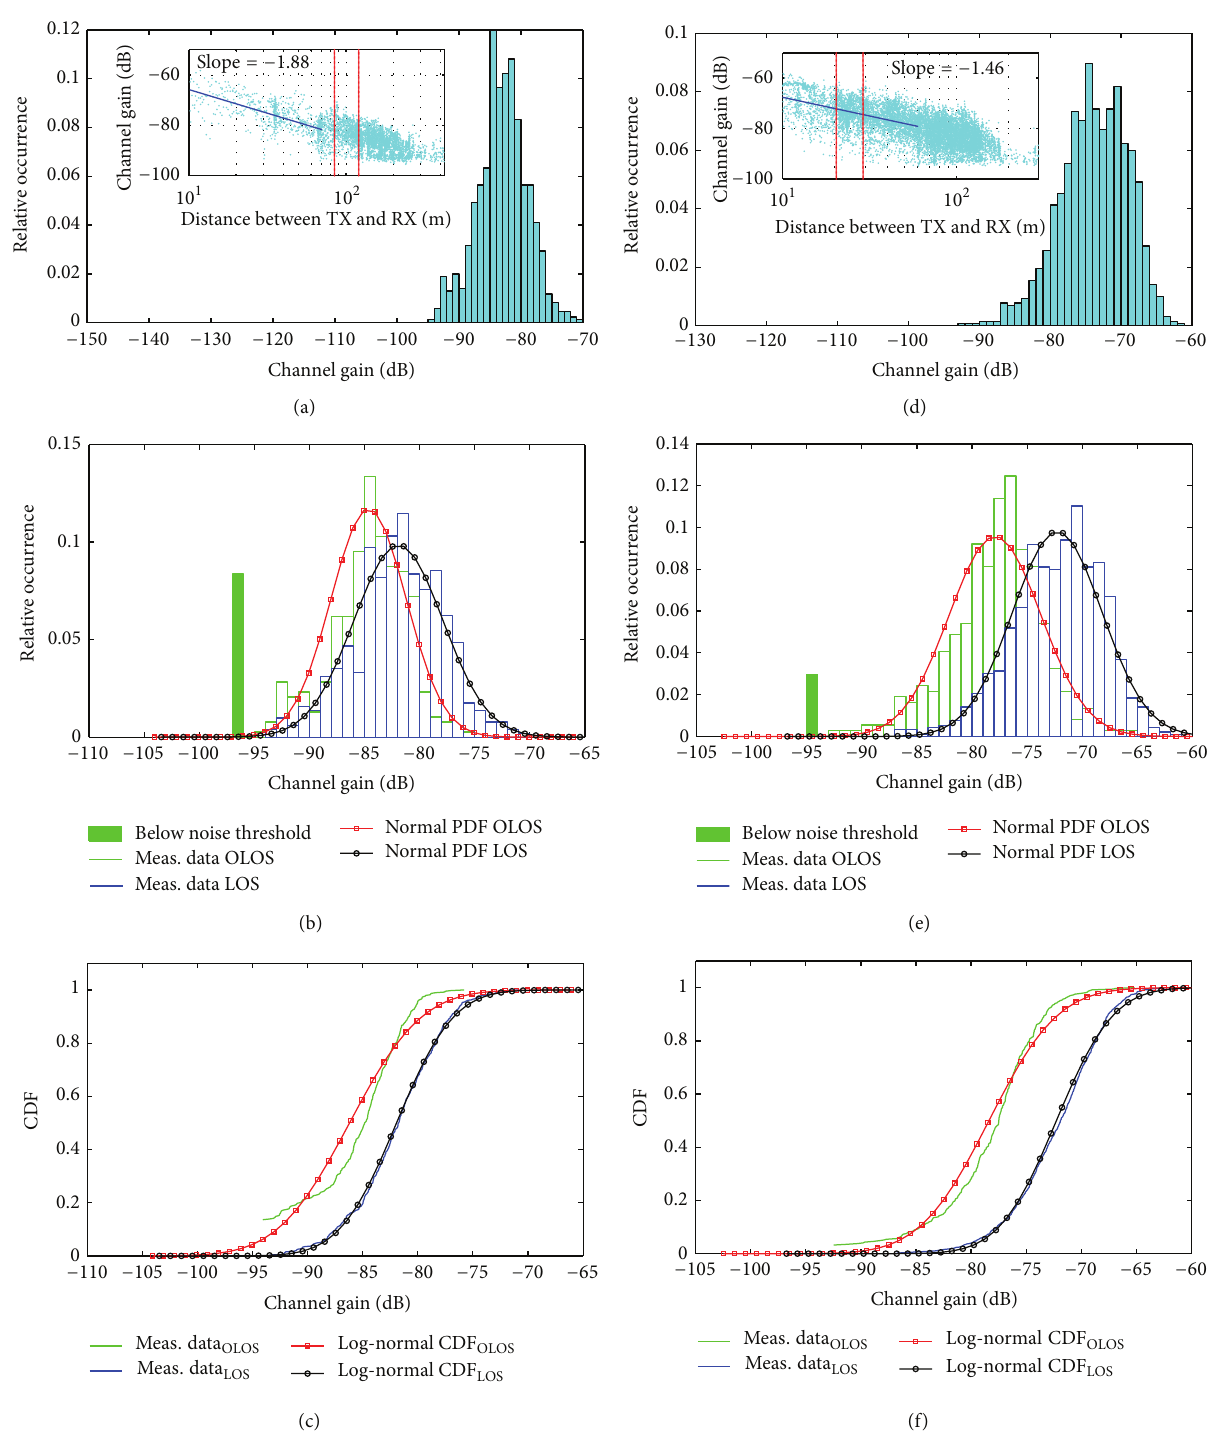
Figure 4: a, b, and c represent highway data, and d, e, and f represent urban data. In (a) and (d) inset plots show channel gain for the overall measurement data as a function of direct distance between TX and RX. The slopes are provided up to the distance where no sample is below the noise. Large plot is the histogram of channel gains taken from log spaced distance bin, 20 . 4–29 . 1 m in (a) and 84 . 6–121 m in (d), marked by vertical lines in the inset plot. The LOS and OLOS data is treated together in these figure; (b) and (e) show histogram of the same channel gains shown in (a) and (d), when separated as LOS and NLOS, pdf fitting the Gaussian distribution; (c) and (f) show CDF fitting the log-normal distribution with 95% confidence